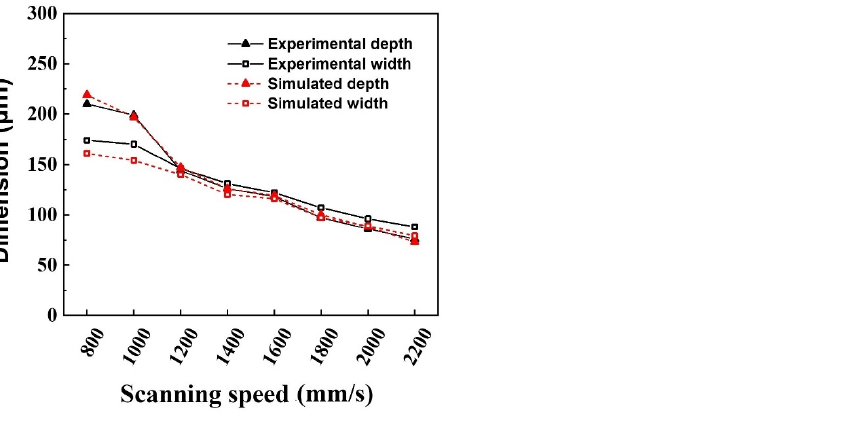
Figure 5. Simulated and experimental melt pool width and depth values.